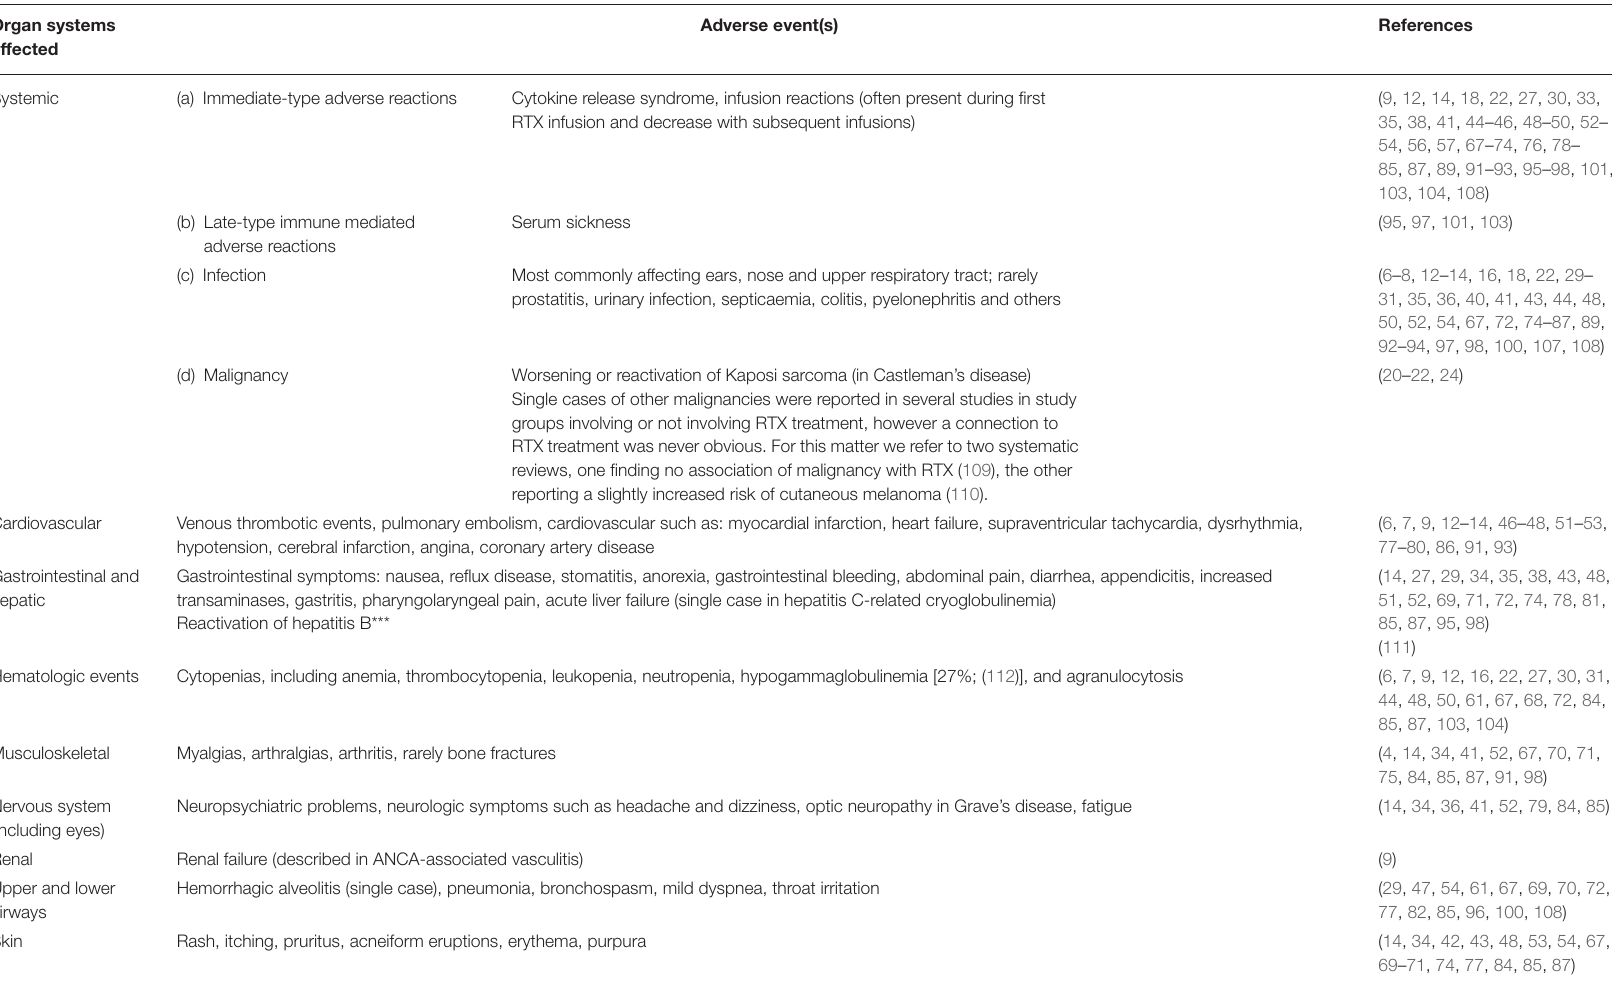
TABLE 4 | Adverse events.